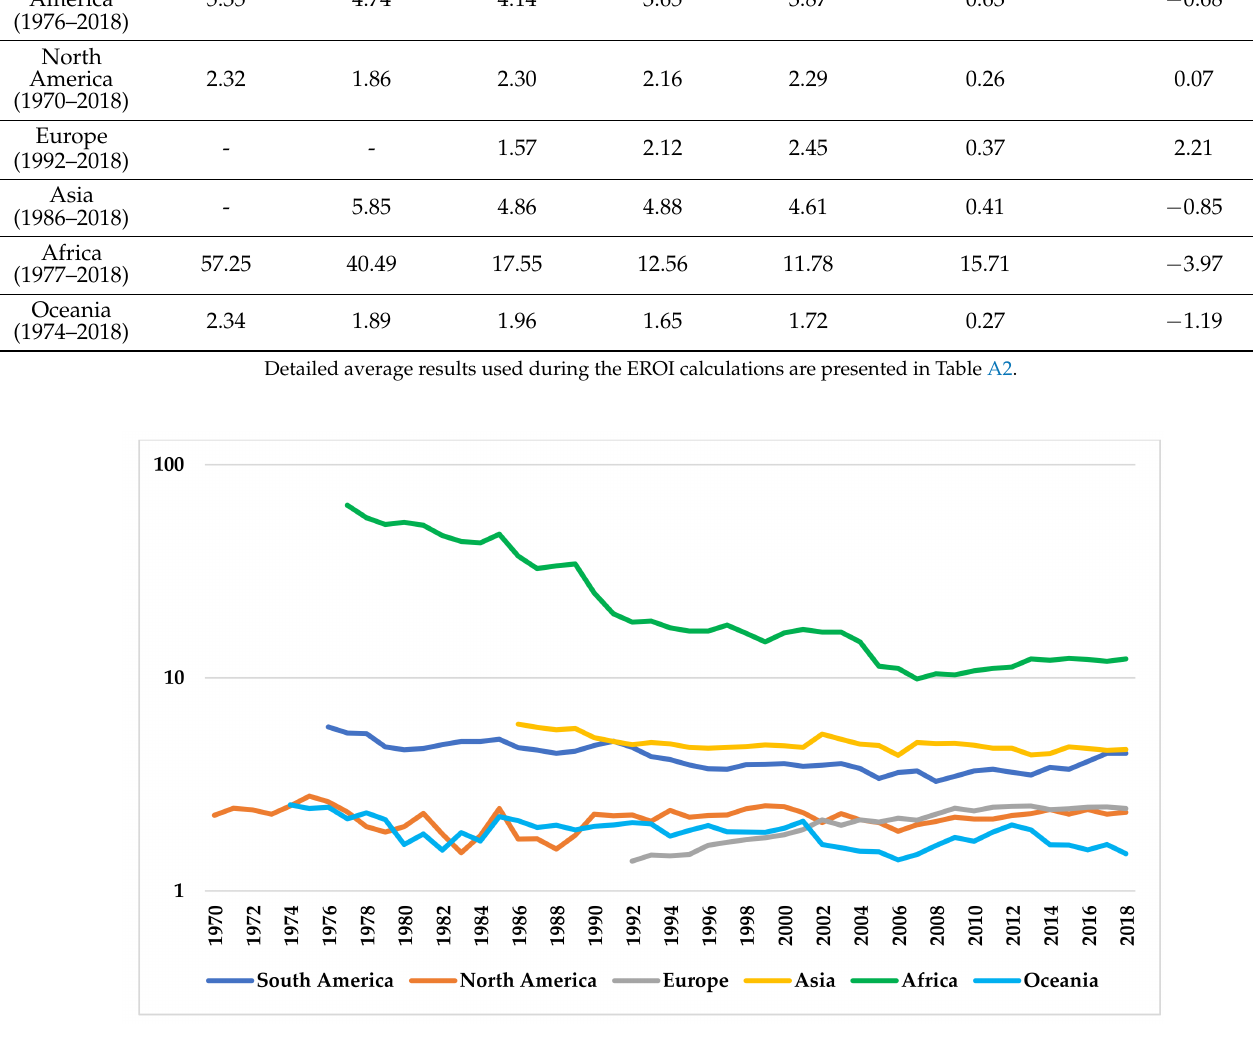
Average Growth Rate (AGR) for Analyzed Period %